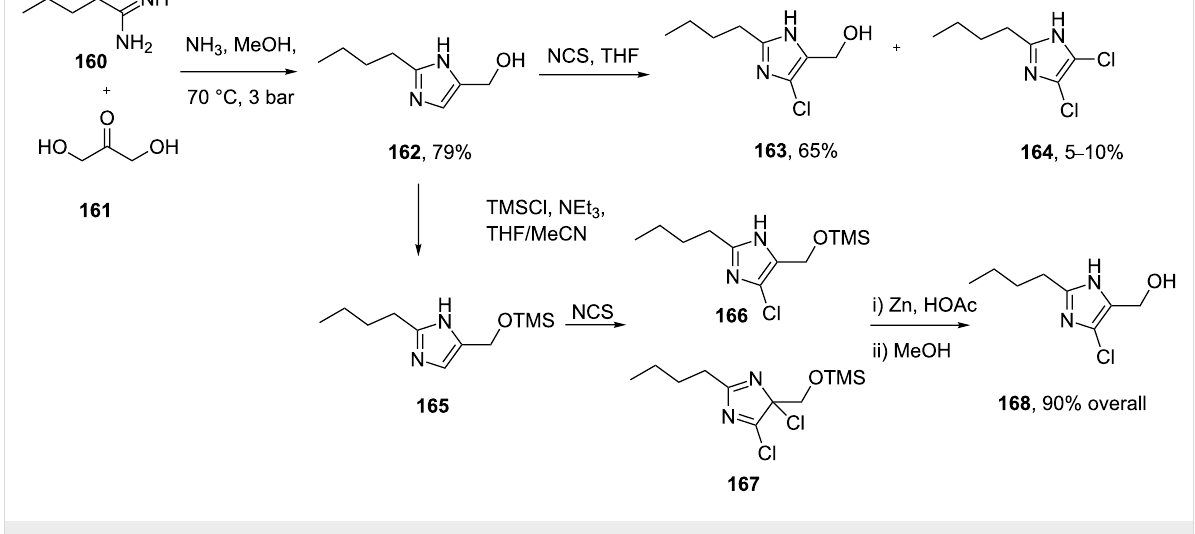
Scheme 33: Synthesis of functionalised imidazoles towards losartan.